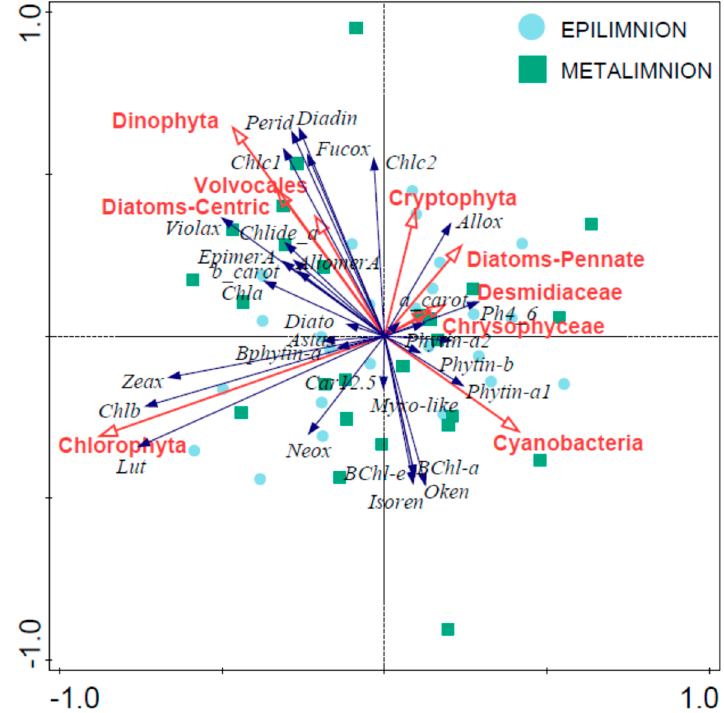
Figure 8. Redundancy analysis (RDA) between phytoplankton taxa (biovolume; mm 3 · L − 1 ) and marker pigments (concentration; µ g · L − 1 ). Red arrows are explanatory variables (53% of the variance in pigment concentration was explained by phytoplankton taxa), blue arrows are response variables (pigments). Diadin: diadinoxanthin; Fucox: fucoxanthin; Chlc2: chlorophyll-c2; Allox: alloxanthin;